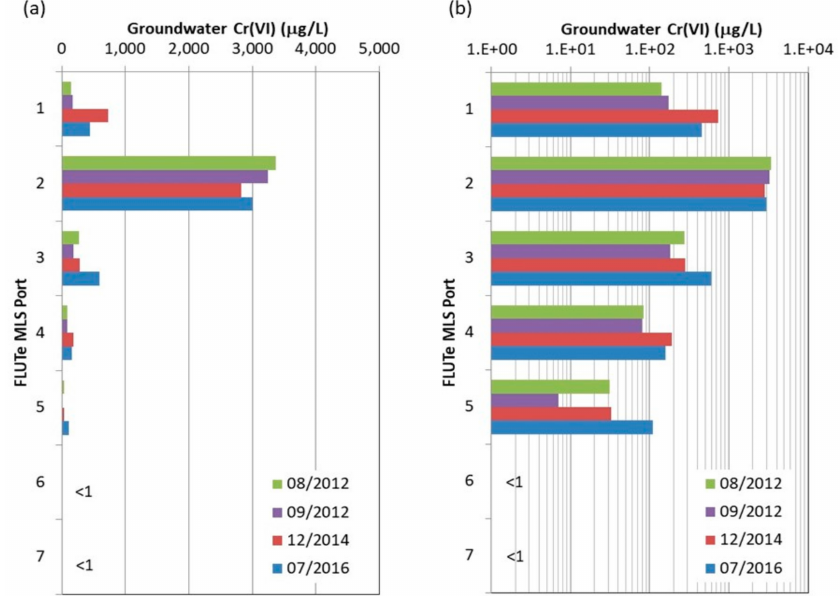
Figure 5. Temporal Cr ( VI ) groundwater sampling results from the EPA-21BR Water FLUTe MLS for two sampling events in 2012, one in 2014 and the comprehensive sampling event in 2016, plotted on ( a ) linear and ( b ) logarithmic concentration scales. Cr ( VI ) in the two deepest ports (ports #6 and #7) have remained below MDLs for all sampling